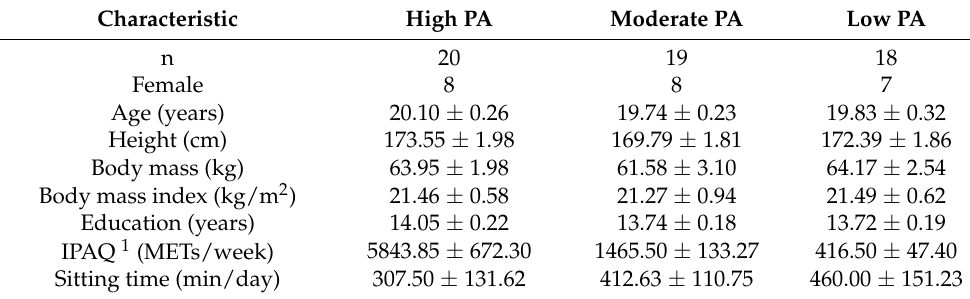
Table 1. Demographic characteristics of 57 included participants (mean ± standard